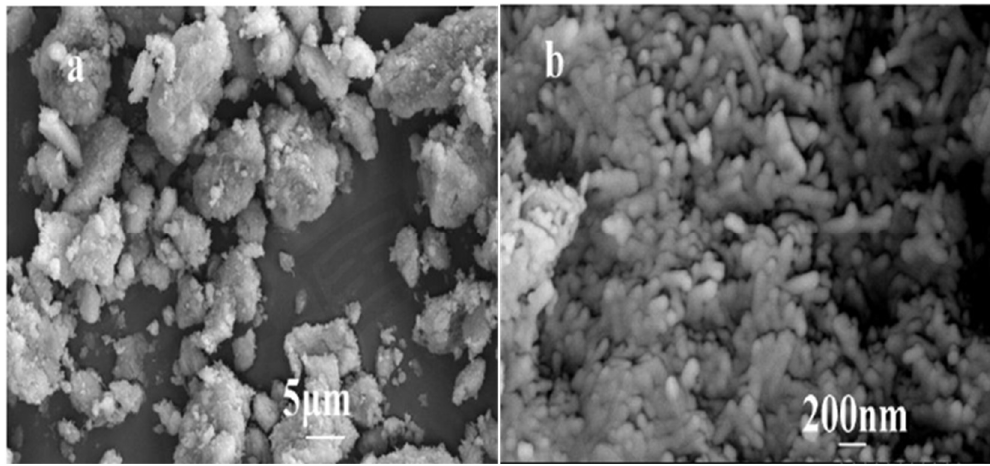
Figure 2. SEM images of the prepared goethite, ( a ) 5 magnification, ( b ) 200 magnification.